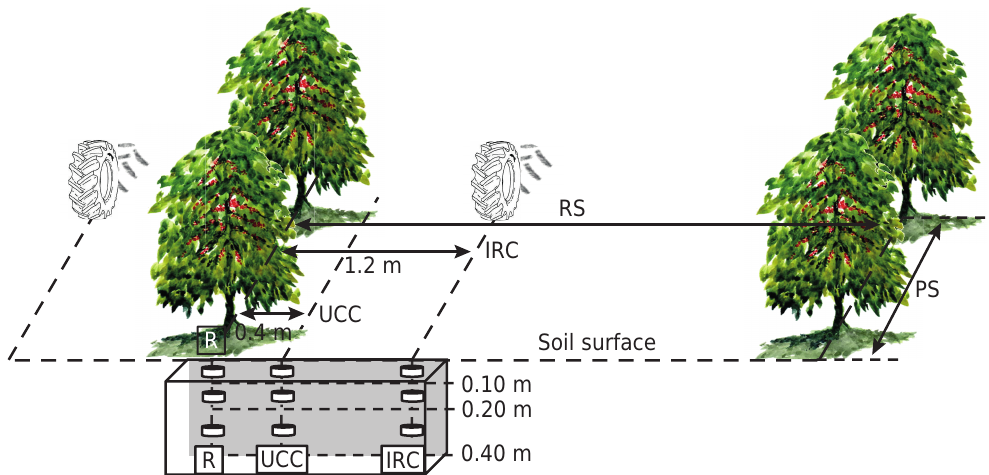
Figure 1. Sampling scheme of undisturbed and disturbed soil samples in coffee plantation areas. R: planting row; UCC: under the coffee canopy; IRC: inter-row center; RS: spacing between planting rows (3.6 m for 3 and 16-years areas, and 4.0 m for 32-years area); PS: spacing between plants (0.6 for 3- and 16 years areas, and 1.5 m for 32-years